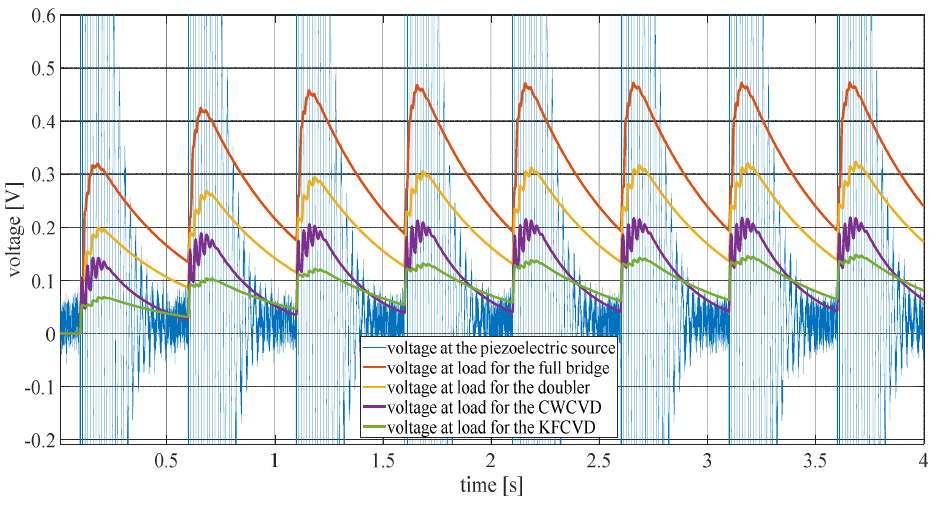
Figure 18. Voltage increases with different raindrops.